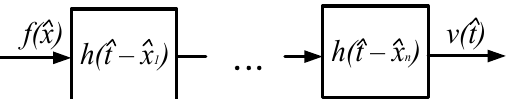
Figure 7. Generalized model of the multiscan-based optoelectronic device.